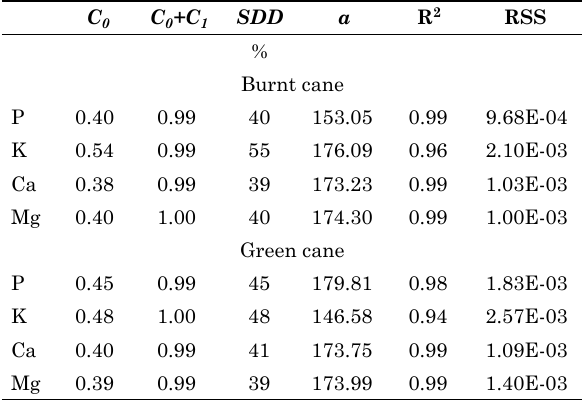
Table 2. Parameters of exponential models fitted to experimental variograms of p, K, ca and Mg soil depletion rates in burnt and green sugarcane harvest